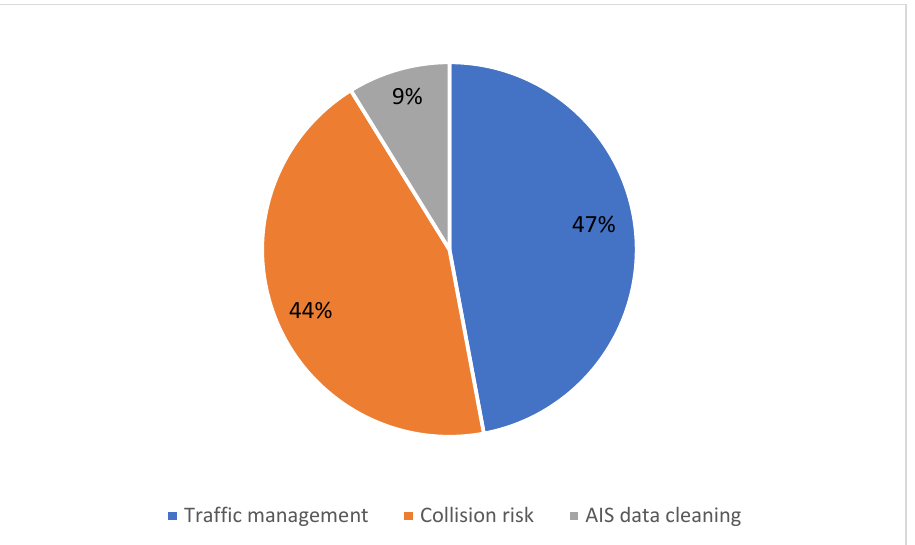
Figure 5. Subdomains in traffic monitoring.